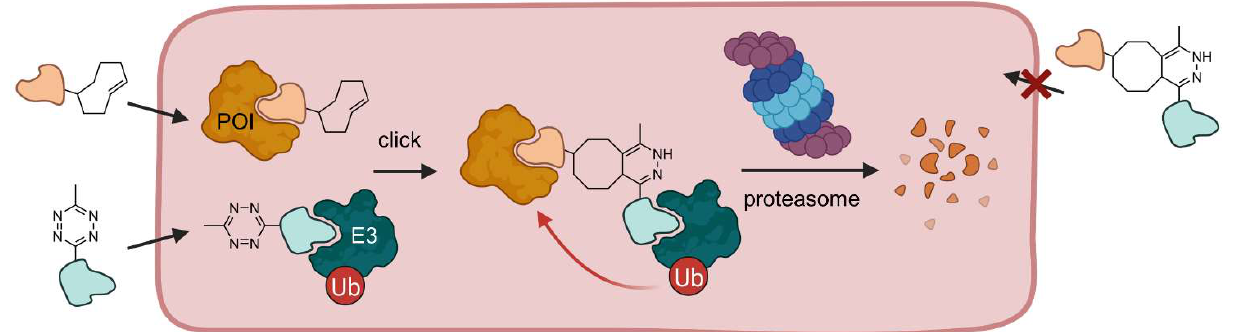
Figure 9. Click-formed PROTACs (CLIPTACs) can be generated in vivo. Cells are incubated with a cyclooctene-functionalized POI ligand and a tetrazine-derivatized E3 ligase ligand in a sequential manner. Both small molecules are cell permeable and undergo a click reaction in the cell. If the click reaction takes place beforehand, i.e., outside the cell, the PROTAC is not able to penetrate the cell membrane [36].